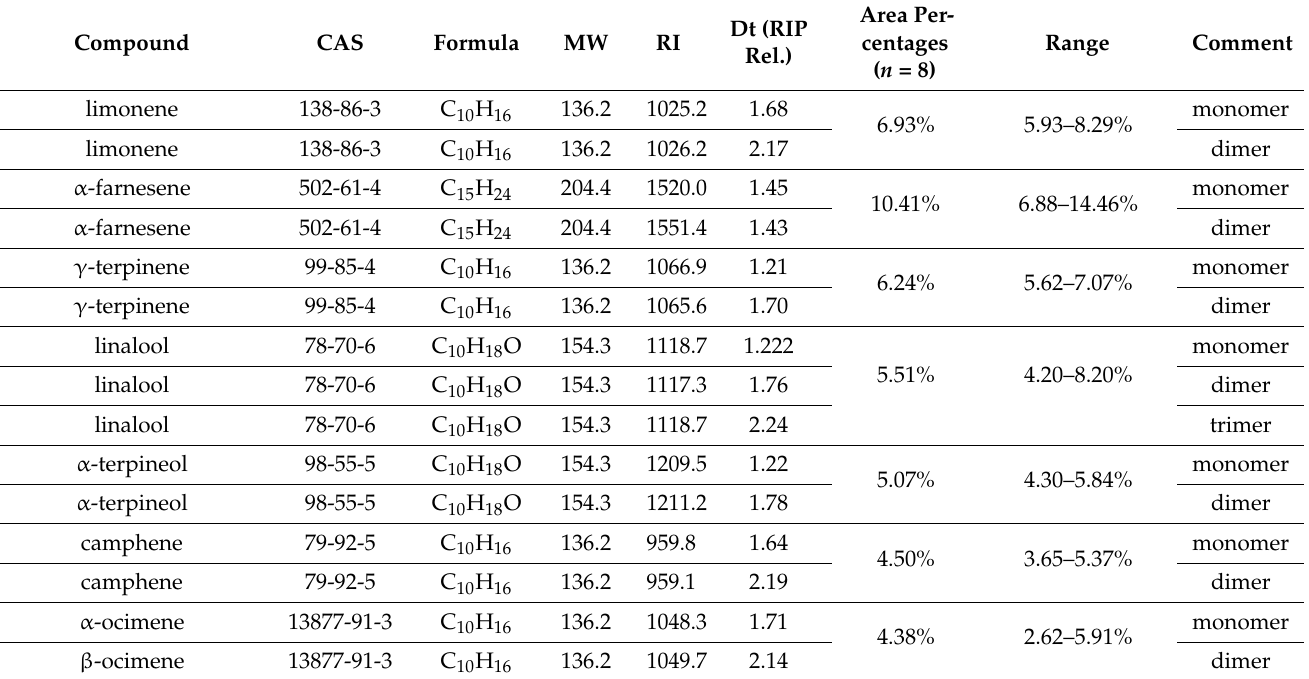
Figure 1. The three−dimensional spectrum of volatile compounds in Qu Aurantii Fructus. Figure 1. The three-dimensional spectrum of volatile compounds in Qu Aurantii Fructus. Table 1. The specific information and relative contents of volatile compounds in Qu Aurantii